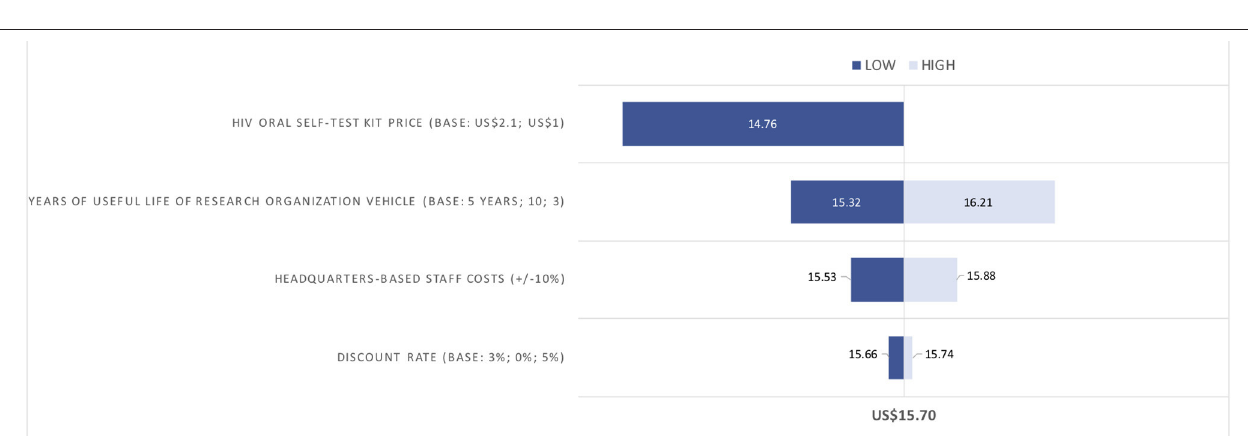
FIGURE 2 | Sensitivity analyses on the costs per person tested (in 2018